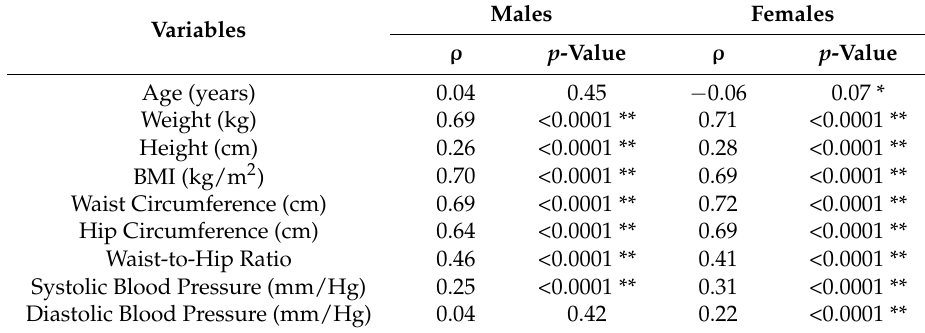
Table 2. Relationships between neck circumference and various anthropometric